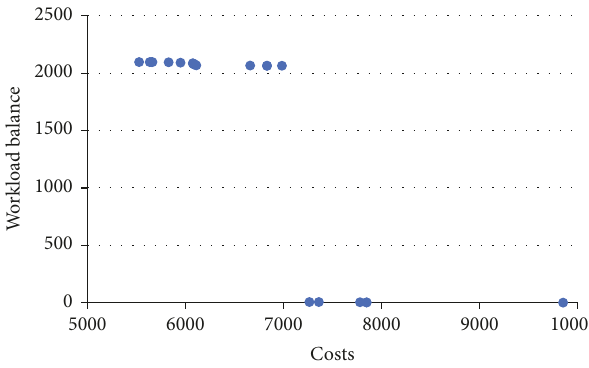
Figure 3: Approximation of the Pareto front of Instance 2.